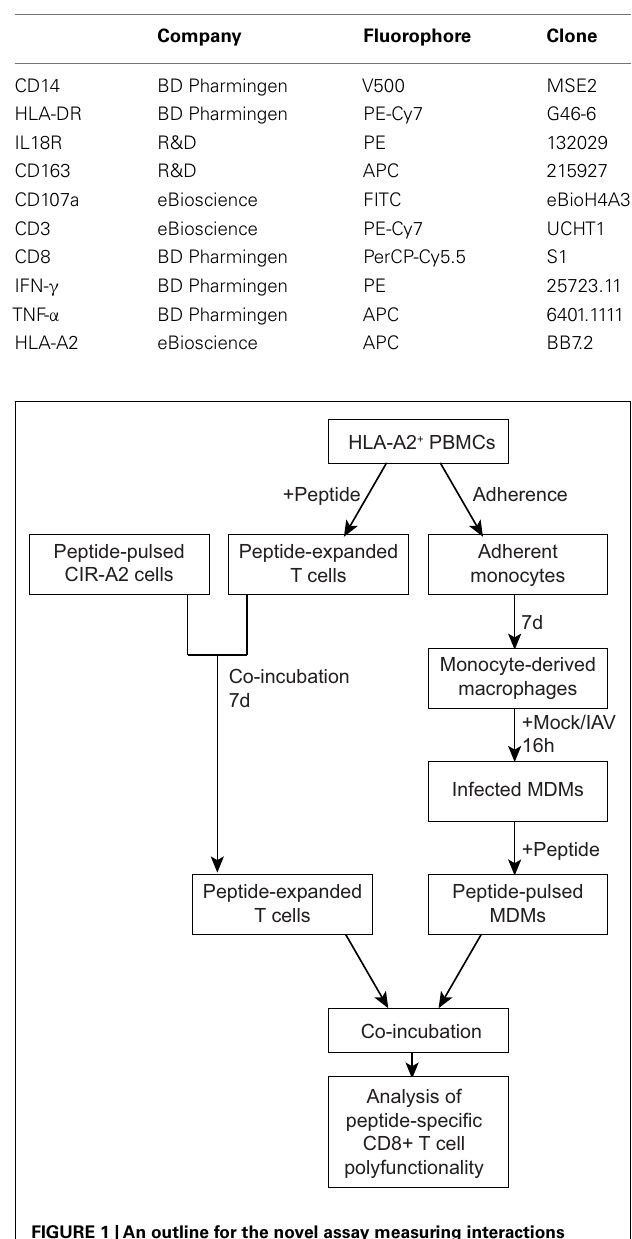
Table 1 |Antibodies used in the study.